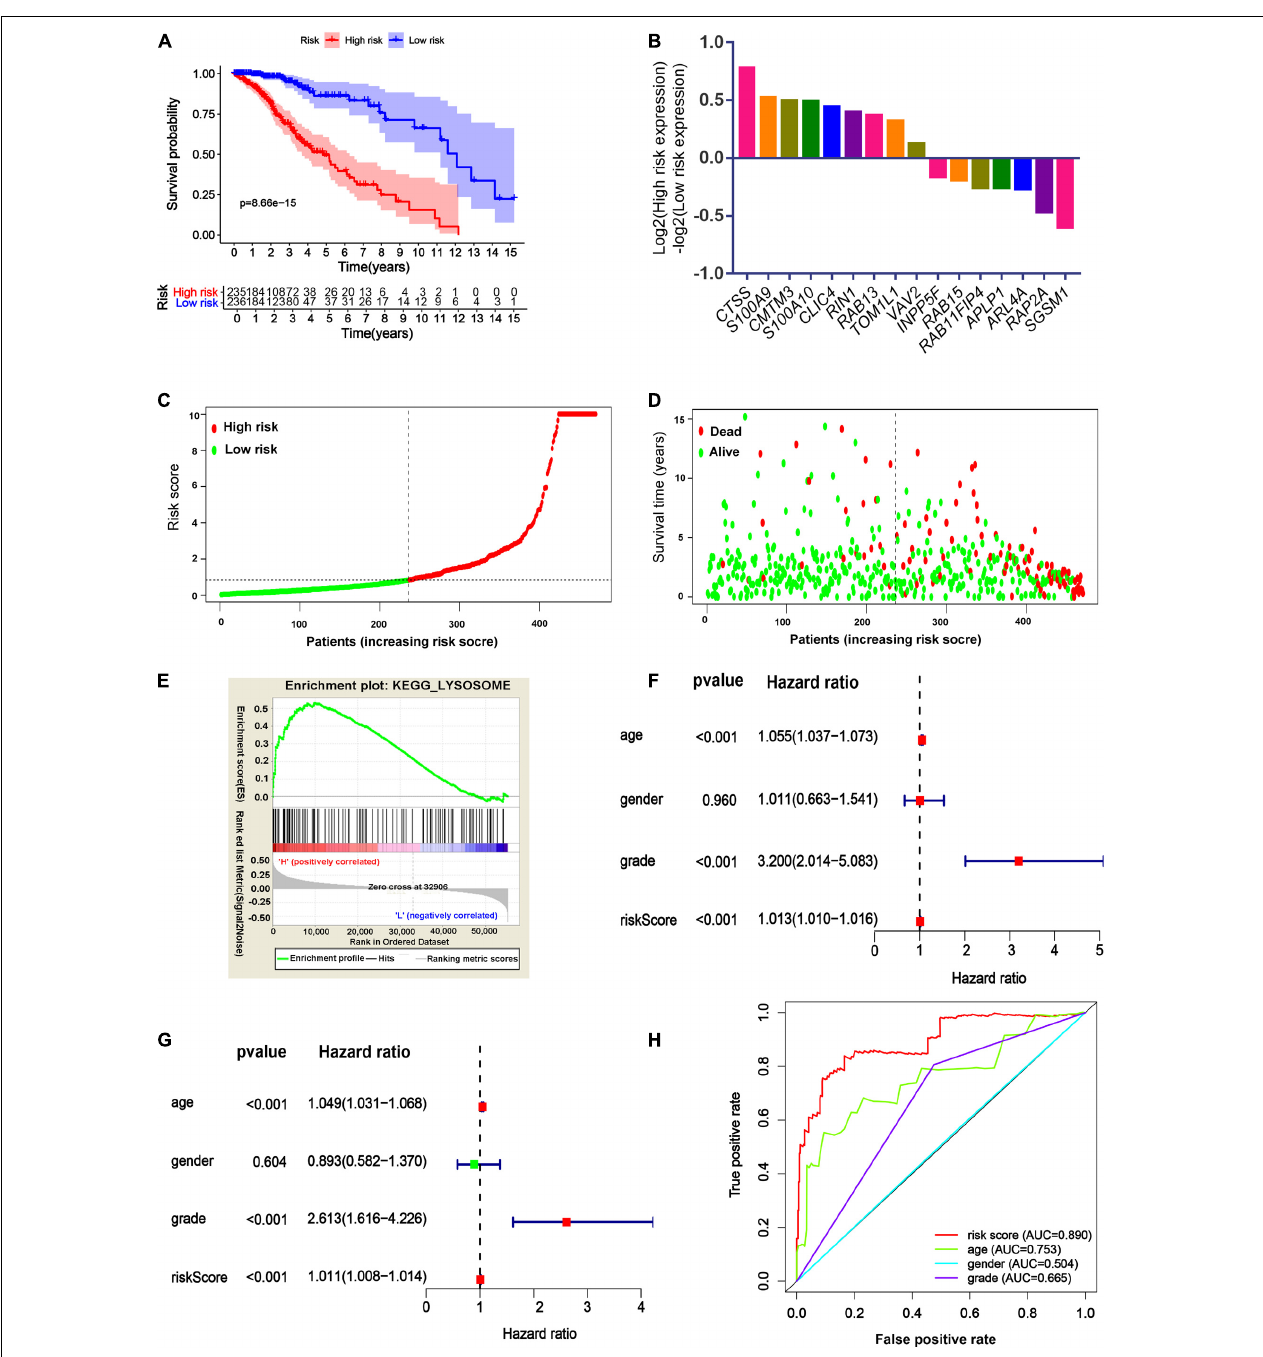
FIGURE 5 | Identification of 29-ERGs signature for the prognosis of TCGA-LGG cohort. (A) Kaplan–Meier analysis of the overall survival of low-risk and high-risk LGG patients stratified by the median risk score. (B) The expression of 16- DEERGs in low-risk and high-risk LGG patients. (C,D) The distribution of risk score and patients’ survival status between low- and high-risk groups. (E) GSEA analysis of KEGG pathway enriched in the high-risk groups. (F) Univariate Cox regression analysis (G) Multivariate Cox regression analysis. (H) Muti-index of ROC curve.